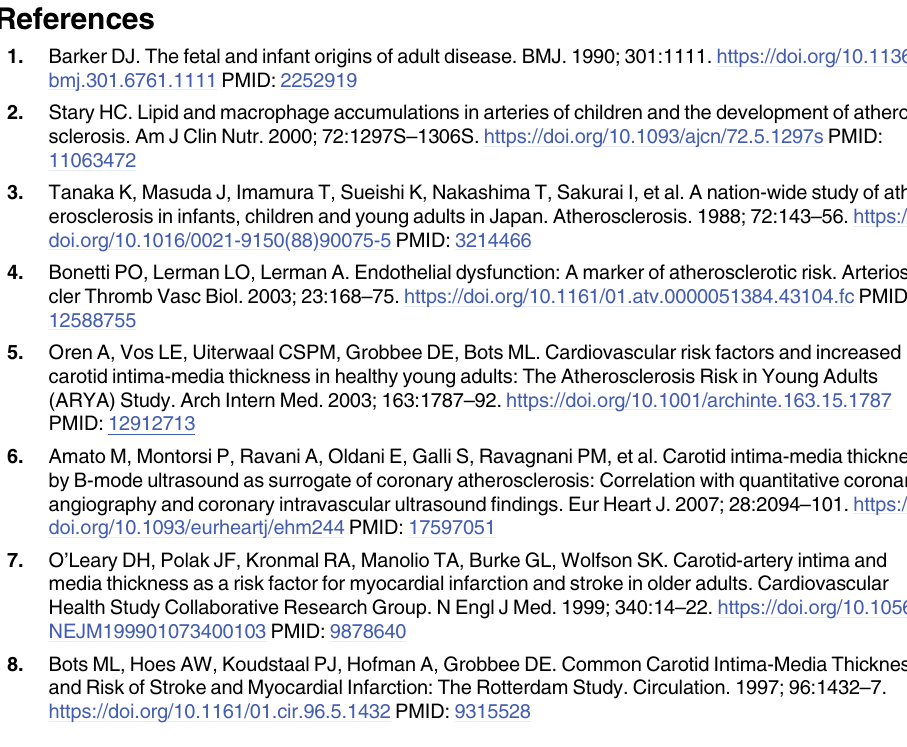
S6 Table. Association of birthweight for gestational age or birthweight and adult IMT. AGA: appropriate for gestational age, LGA: large for gestational age, SGA: small for gestational age. AGA, LGA and SGA defined according to German sex-specific birth weight and length- for-gestational-age curves. Linear trends (P difference) were obtained in linear regression models with IMT as a continuous variable and birthweight according to gestational age as a 3 level categorical variable (0 = SGA; 1 = AGA; 2 = LGA with AGA set as the reference category in the models). 1 p difference and trend less than 0.025 are considered significant according to Bonferroni adjustment. 2 Values are frequencies (percentages) of birthweight according to ges- tational age. 3 Values are adjusted least squares means (95% CIs) of IMT. 4 Values are medians (25th, 75th percentiles) of birthweight. Model A adjusted for adult age at IMT measurement and the physician taking the IMT measurement. Model B additionally adjusted for birth year (residuals of birth year were calculated on age at IMT